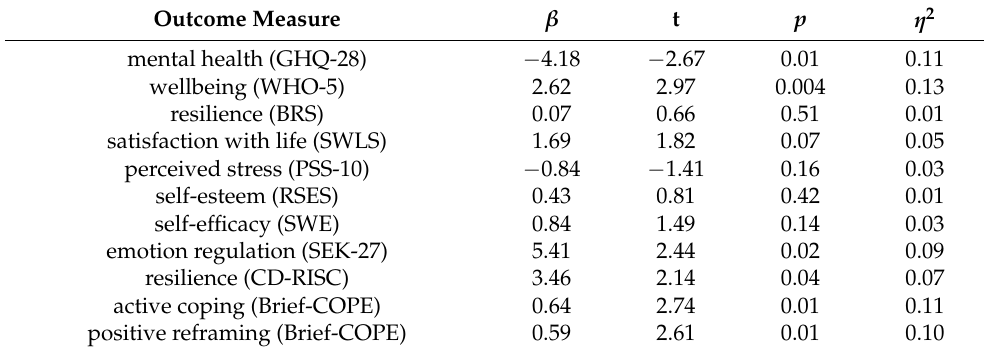
Table 4. Results of group differences over the follow-up period (t1–t4) using linear mixed model analysis adjusted for the outcome at